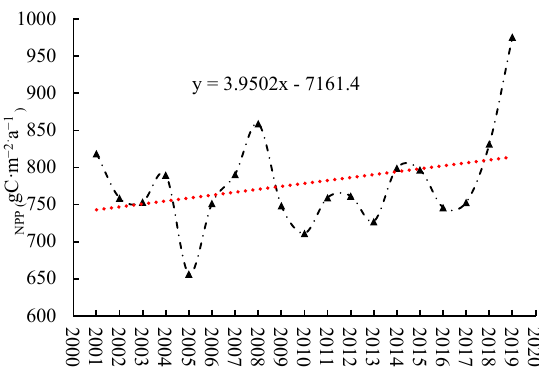
Figure 6. Inter-annual variation of NPP, from 2001 to 2019, in Northeast China.